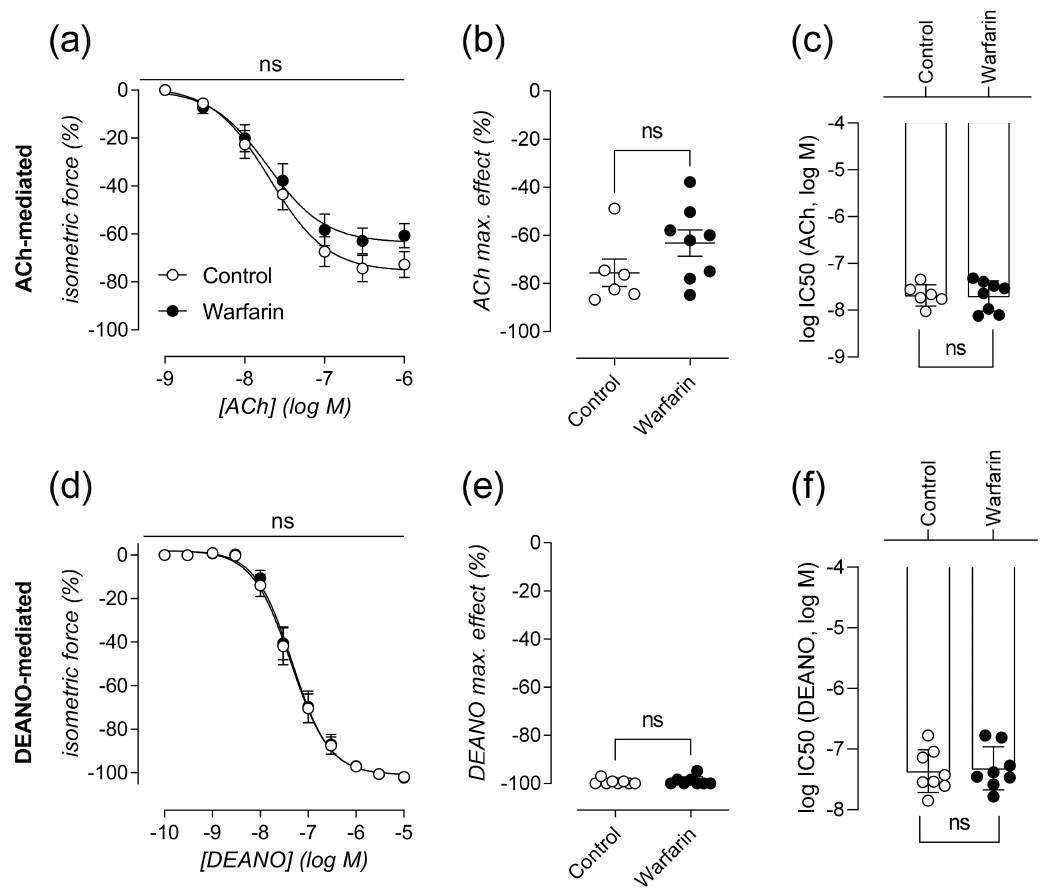
Figure 3. Vascular smooth muscle cell relaxation remains largely unaffected in calcified aortas. Relative isometric force is shown in relation to increasing concentrations of ACh (%) ( a ) leading to relaxation of the aortic segment. Maximal ACh-mediated relaxation (%) ( b ) and sensitivity to ACh (logIC50) ( c ) are shown. In the presence of L-NAME, the relative isometric force is shown in relation to increasing concentrations of DEANO ( d ). Maximal DEANO mediated relaxation (%) ( e ) and sensitivity to DEANO (logIC50) ( f ) are shown. ACh:(Control: n = 6, Warfarin: n = 8), DEANO:(Control: n = 8, Warfarin: n = 8). Two-way ANOVA with Sidak correction was performed for the dose response curves. ( a , d ). Two-tailed Mann-Whitney U test was used to assess statistical significance between two groups ( b – f ). Significance summary or vs. control: p > 0.05: ns. Lines/bars and error bars represent mean ± SEM ( a , d ) and mean ± SD ( b – f